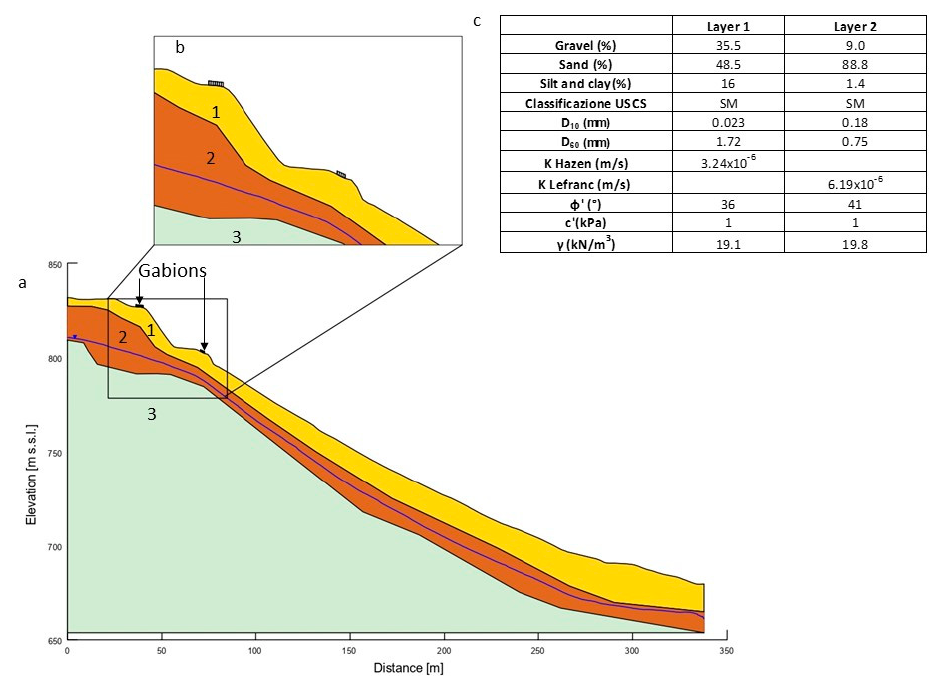
Figure 9. Rainfall path of the ( a ) November 2016; ( b ) November 2019; and ( c ) October 2020 Figure 9. ( a ) Geotechnical slope model along section A–A’ reconstructed along the line of maximum slope for the last landslide event. 1: Layer 1, sand with gravel; 2: Layer 2, weakly gravelly sand; and 3: Layer 3, bedrock. ( b ) Zoom of the area with the locations of the gabions. ( c ) The table shows the geotechnical and hydrological parameters of the two modelled layers.